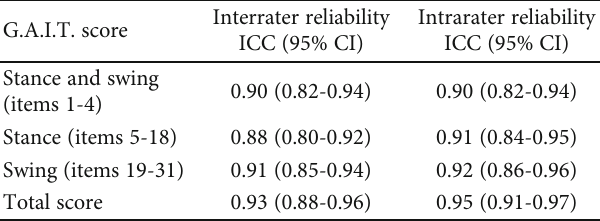
Table 3: Reliability of Thai G.A.I.T. scale classi fi ed by 3 main items. G.A.I.T. score